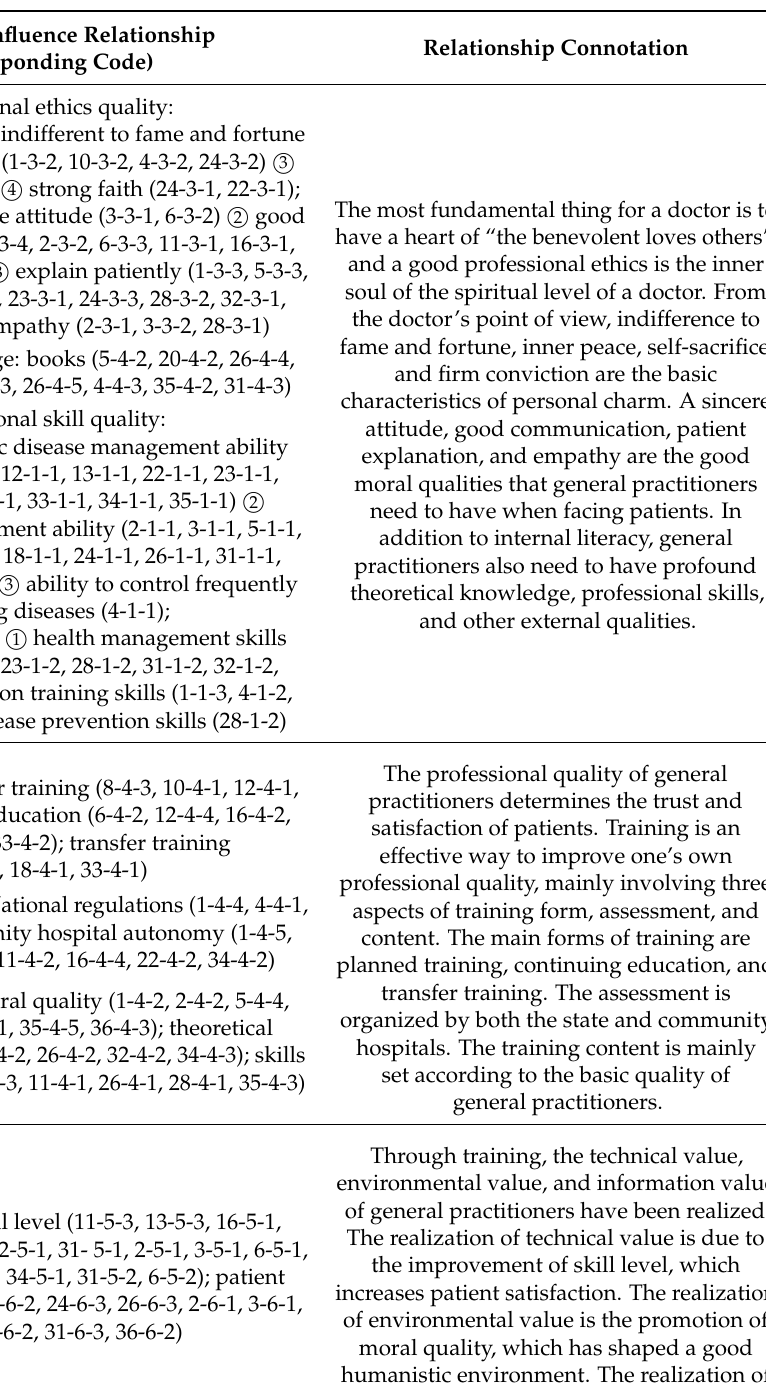
Table 3. Three types of relationships based on axial